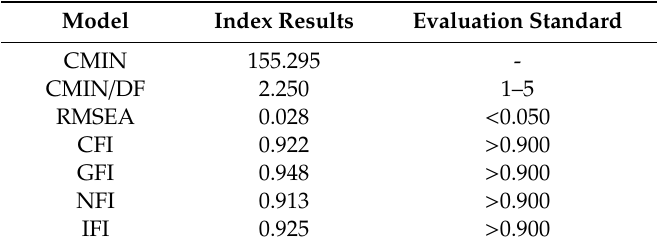
Table 3. Comparison of the revised model fit index results with the evaluation standard.